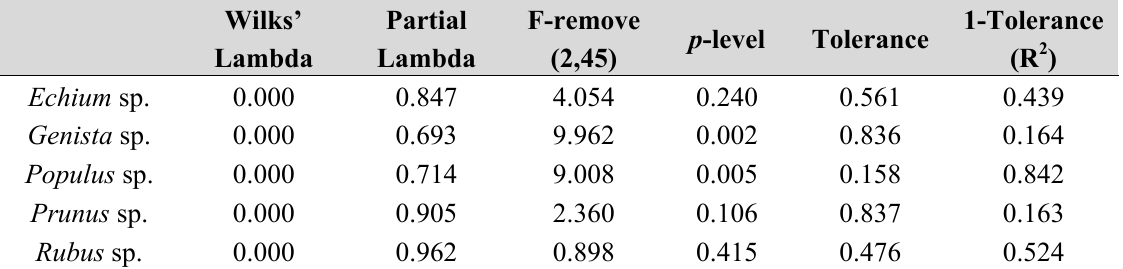
Table 3. Results of stepwise discriminant analysis (SDA) of palynological parameters in the three harvests of PDO